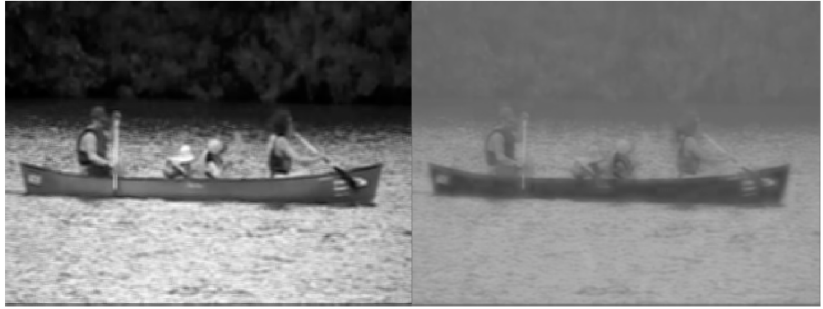
Figure 3. Two CNN features with the maximal PSNR.